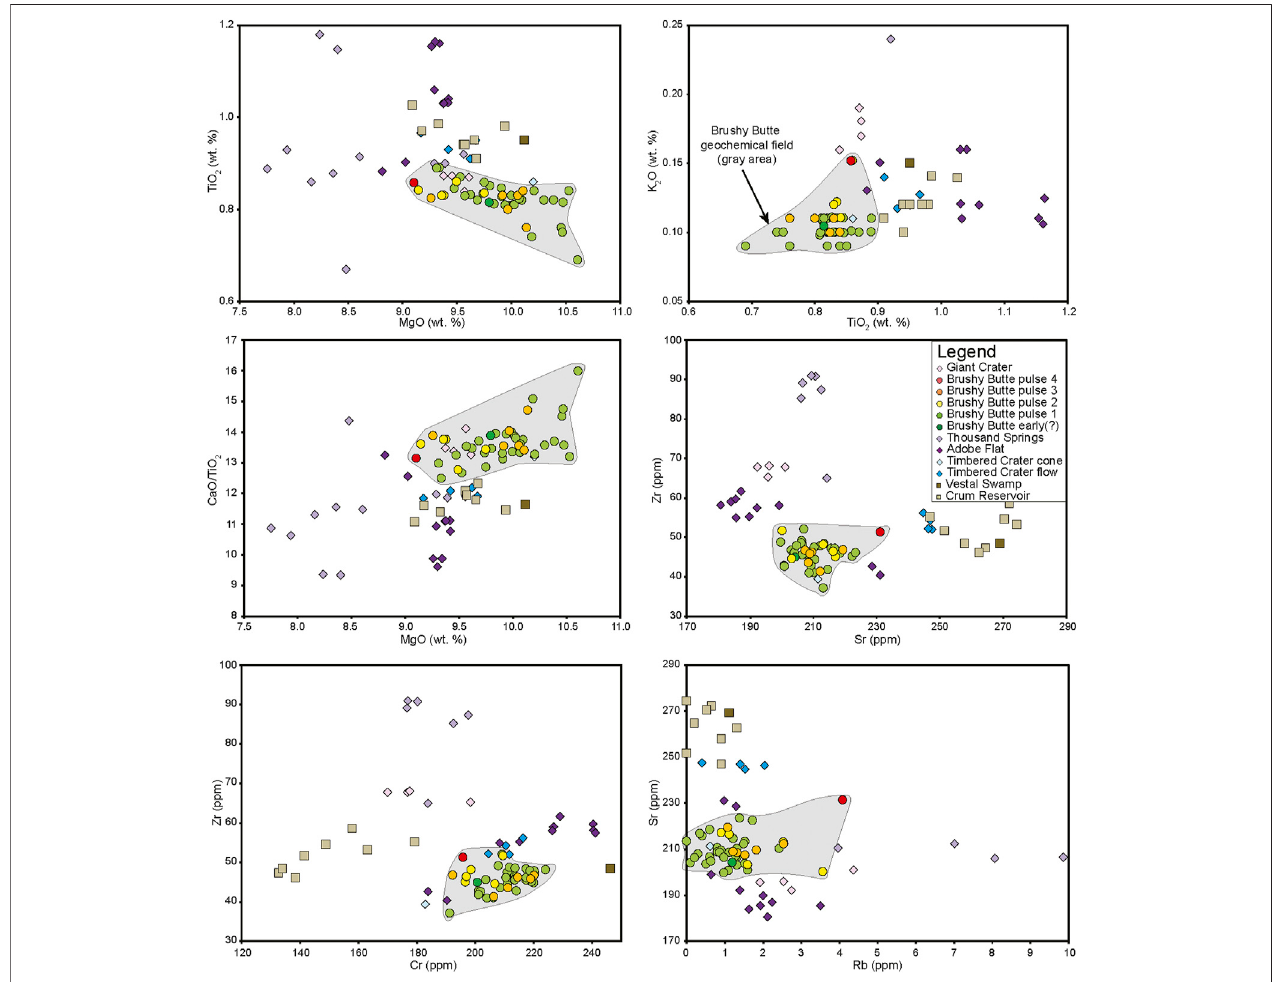
FIGURE 4 | Bivariate plots showing the whole-rock geochemical differences between the Brushy Butte fl ow fi eld (circles surrounded by the solid black line) and surrounding tholeiitic basalts. The entire Brushy Butte geochemical fi eld is shaded gray. See Supplementary Table S2 in the Supplementary Material for all of the geochemical analyses from the Brushy Butte fl ow fi eld and the surrounding tholeiitic basalts.